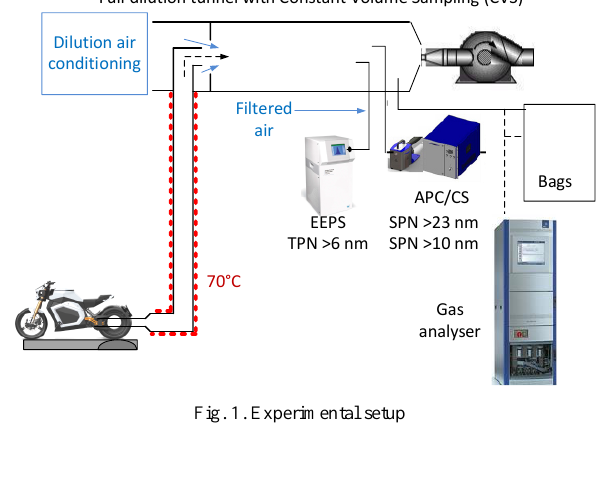
Fig. 1. Experimental